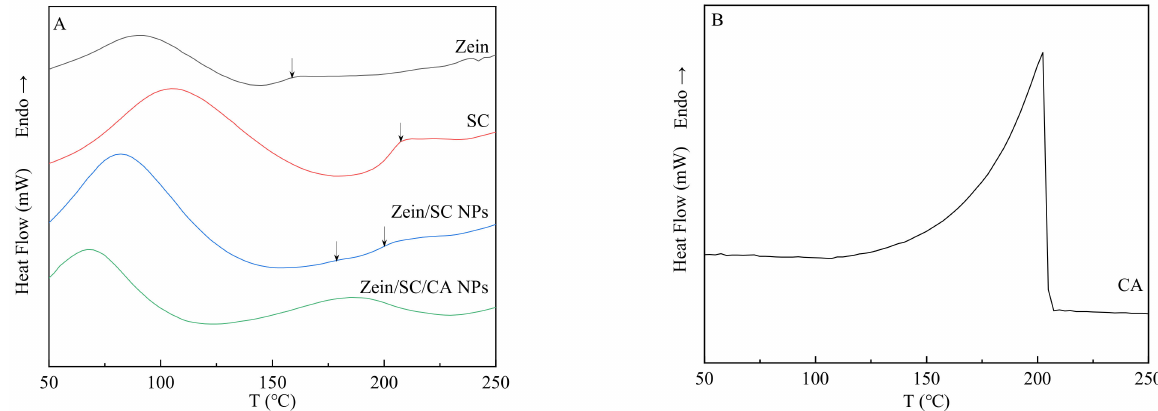
Figure 10. DSC curves of ( A ) zein, SC, zein/SC NPs, and zein/SC/CA NPs. ( B ) Pure CA.